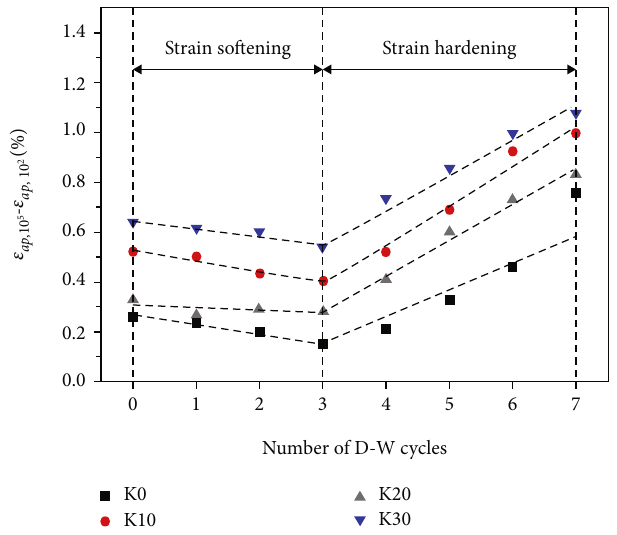
Figure 11: Relationship between permanent strain of GRS and number of D-W cycles in the compression